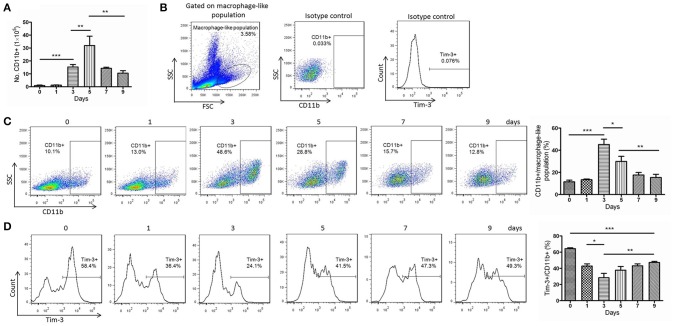
Decreased T-cell immunoglobulin- and mucin-domain-containing molecule 3 (Tim-3) expression in splenic CD11b+ cells from Plasmodium berghei ANKA (PbANKA)-infected mice. Splenic cells of PbANKA-infected C57BL/6 mice were collected at days 0, 1, 3, 5, 7, and 9 post-infection. (A) CD11b+ cells were isolated from splenic mononuclear cells and manually counted. (B–D) The CD11b+ populations and the Tim-3 expression were measured using flow cytometry. (B) The gate strategies and isotype controls. (C) Representative dot plots (left panel) and a histogram (right panel) showing the frequency of CD11b+ cells in the macrophage-like population. (D) Representative dot plots (left panel) and a histogram (right panel) showing the frequency of Tim-3-expressing cells in the CD11b+ macrophage populations. The results are representative of 3 independent experiments with five to seven mice in each group per experiment, with data indicating the mean + SD. *p < 0.05, **p < 0.01, and ***p < 0.0001.